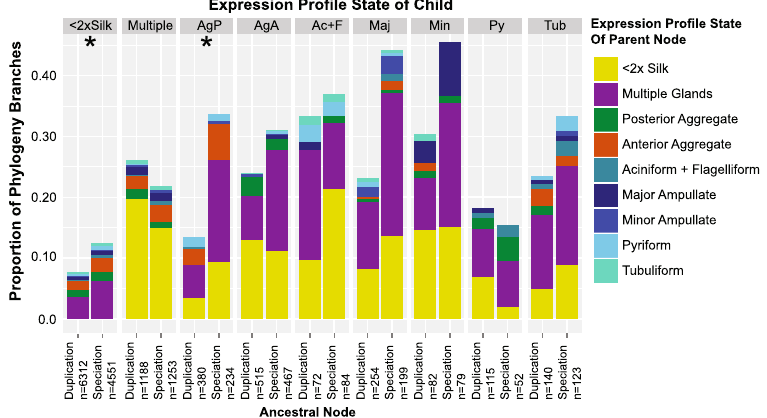
Figure 6. Derivation of silk gland specific expression. Classification of branches in phylogenies inferred for 605 BlastClust clusters containing representatives from all three cobweb weaving species and at least one transcript with expression levels 2-fold higher in silk glands than non-silk glands (see Fig. 7 for exemplar trees and Supplementary File 5 for all phylogenies). Each branch was classified according to whether or not there was a change in expression state between the ancestral node and the descendant. Maximum likelihood ancestral FPKM was determined for each gland type independently. If the mean FPKM was more than 2-fold greater in silk glands than non-silk glands, the node was assigned to the silk gland type with the majority of the expression, or to “multiple” glands if no majority (Supplementary File 4). Branches deriving from duplication and speciation nodes are shown seperately (n = number of nodes). Asterisks ( * ) denote significant differences in changing expression state between duplication and speciation nodes with Fisher’s exact test after Bonferroni multiple test correction. Fisher’s exact test is appropriate here due to the imbalance in number of speciation and duplication nodes and limited instances of changing expression states for some